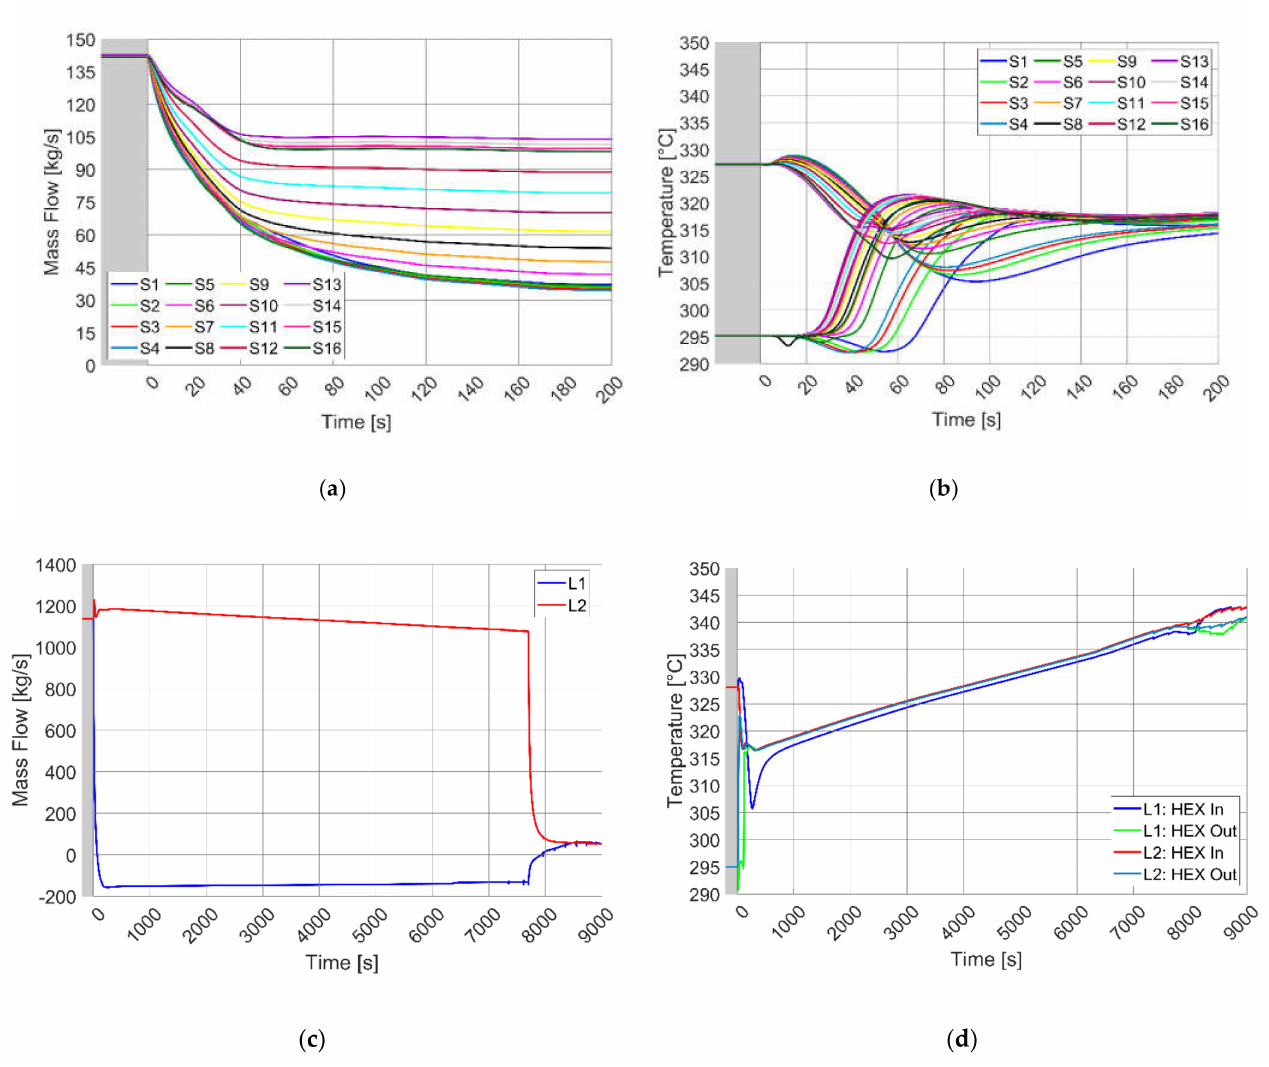
Figure 7. Partial LOFA on FW PHTS without loss of off-site power (LF1 transient): ( a ) Mass flow in FW sectors (early time); ( b ) FW PHTS water temperatures at BB inlet & outlet (all sectors, early time, COB segment); ( c ) Mass flow elaborated by FW PHTS MCPs (full range); ( d ) FW PHTS water temperatures at Heat EXchangers (HEXs) inlet & outlet (full